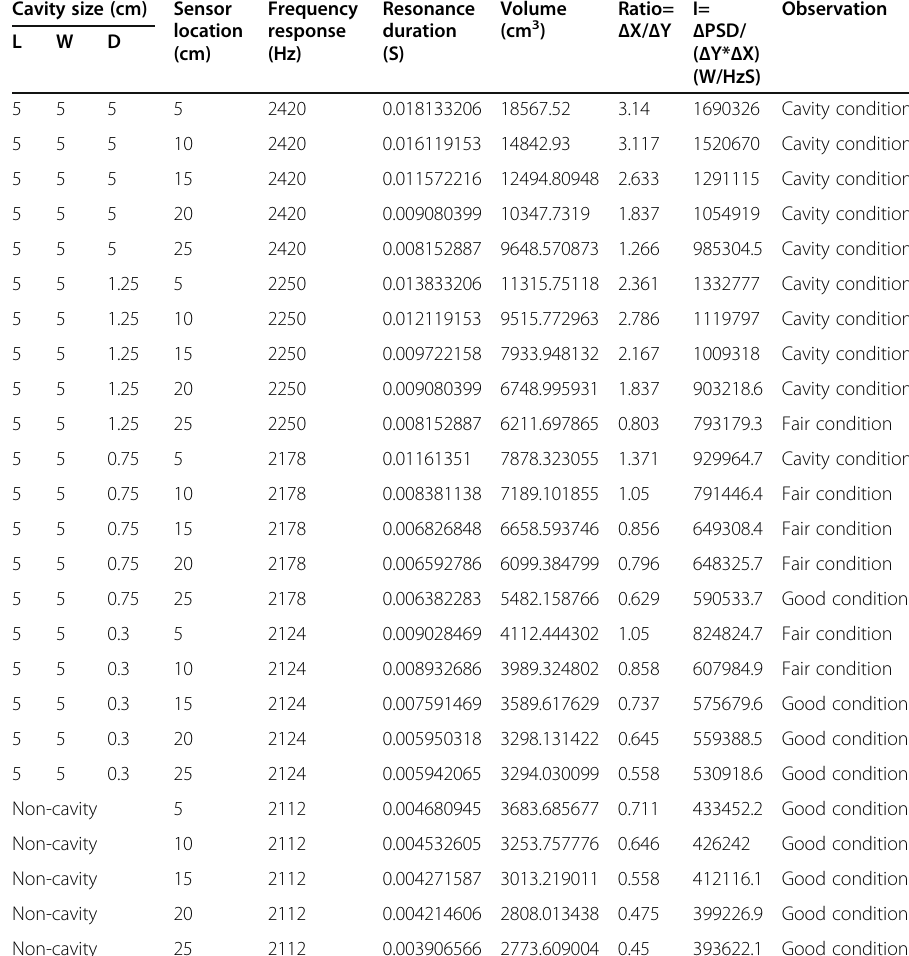
Table 5 FEA results ’ summary for cavity and non-cavity conditions Cavity size